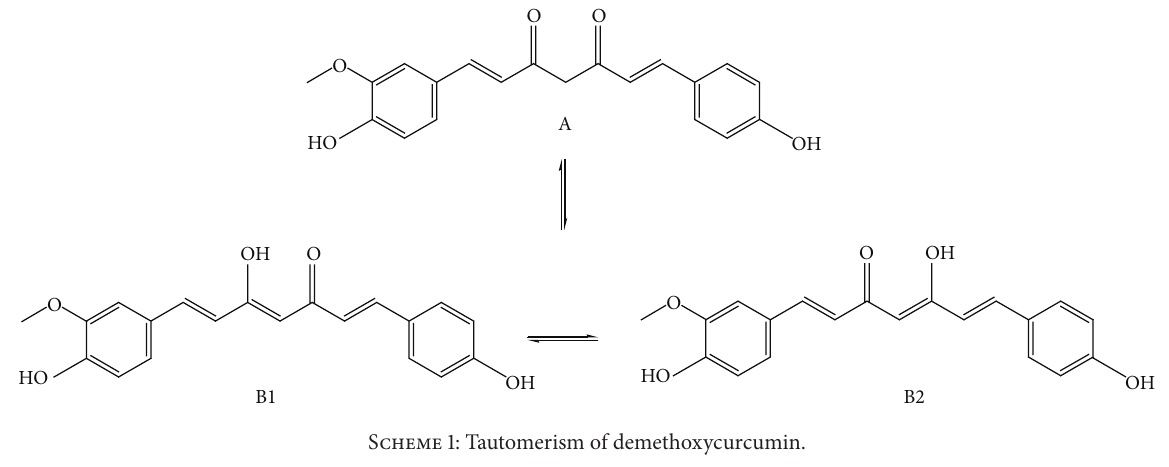
Scheme 1: Tautomerism of demethoxycurcumin.